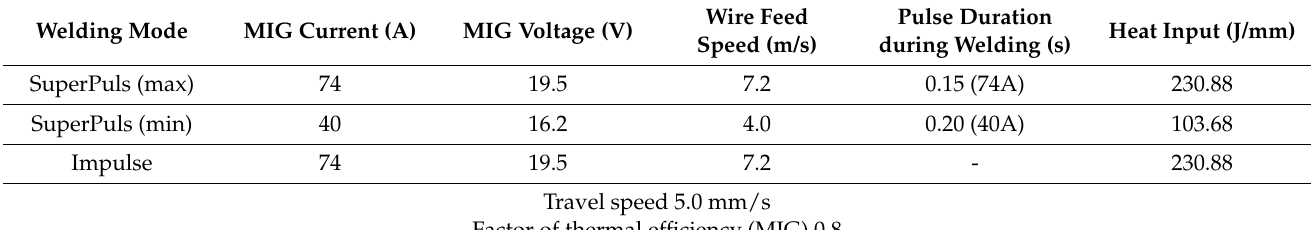
Figure 2. Grooved sheets of different steels’ grades prepared for welding; inlet after welding. Table 3. The main parameters of welding procedure.